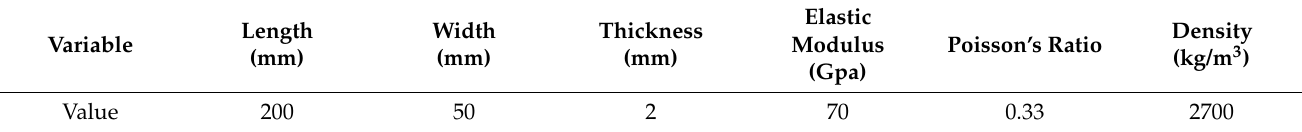
Table 2. Aluminum beam characteristics.